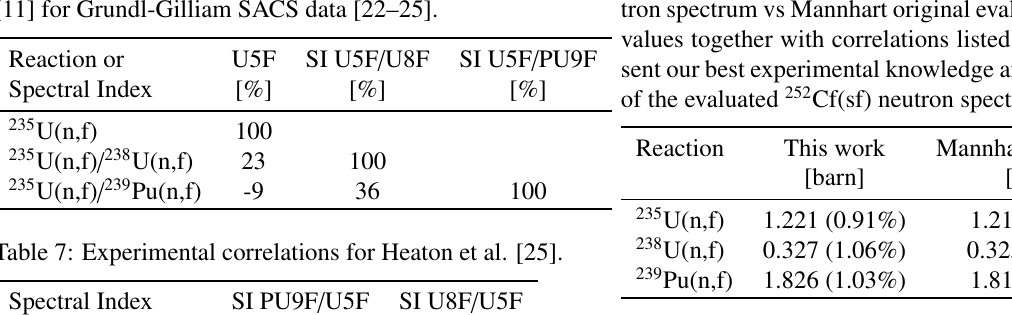
Table 12: Evaluated experimental SACS correlations in 252 Cf(sf) neutron spectrum of major-actinide fission cross sections corresponding to mean values and uncertainties listed in Table